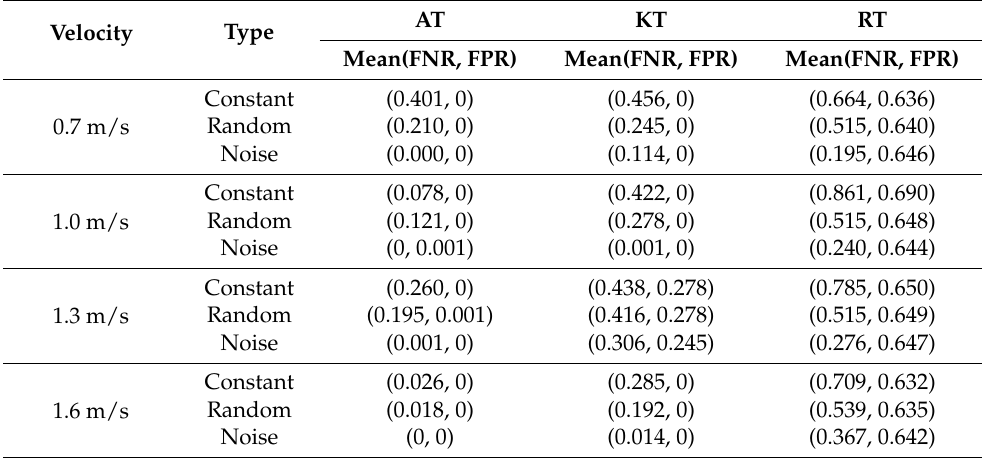
Table 2. The false negative rate (FNR) and false positive rate (FPR) of the experimental results for all scenarios are